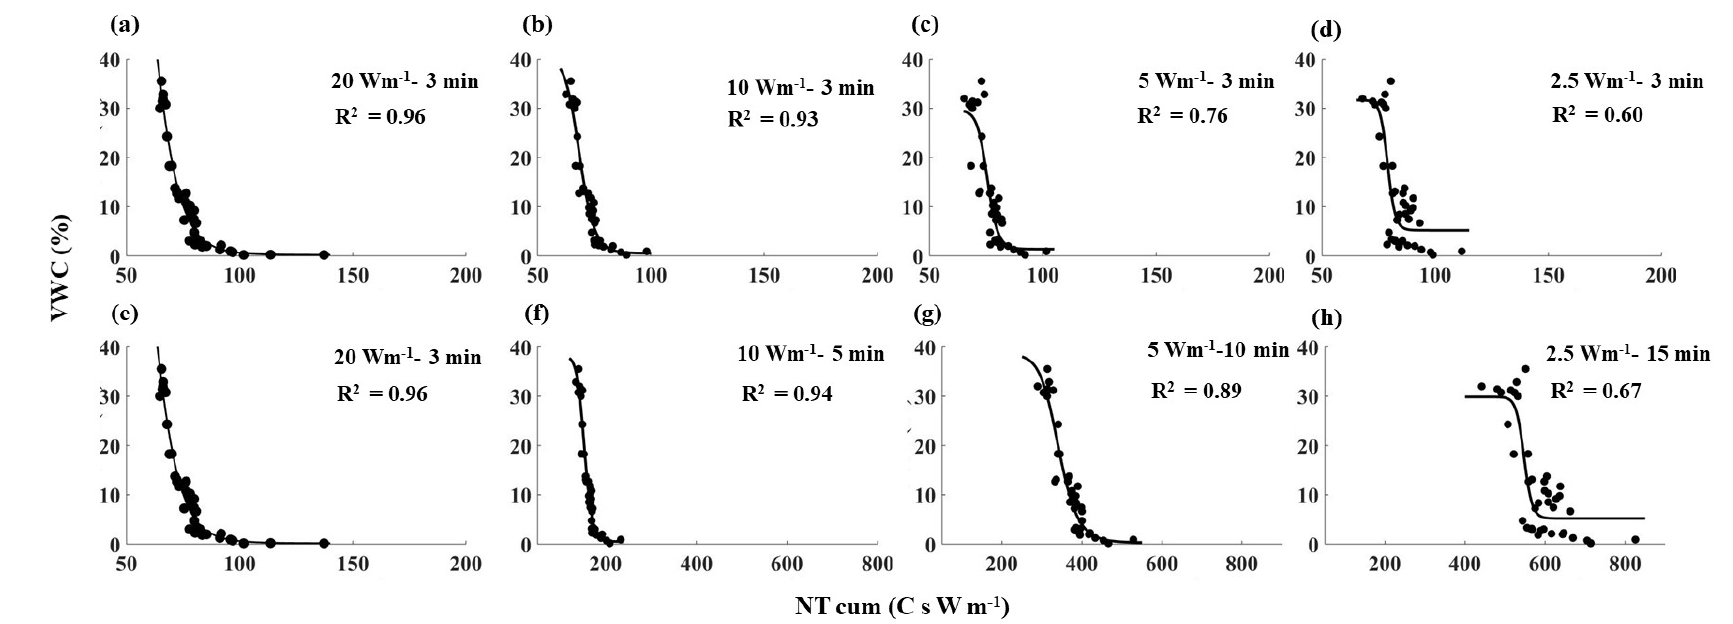
Figure 5. NT cum as a function of VWC for all the heating strategies tested in sandy soil. The black dots show the observed values, and the black solid lines show the fitted relationships between NT cum and VWC for individual heating strategies. Note: ( a ) and ( e ) are similar (20 Wm − 1 –3 min) and used to compare with the short pulses (along the row 1) and with the long pulses (along the row 2).